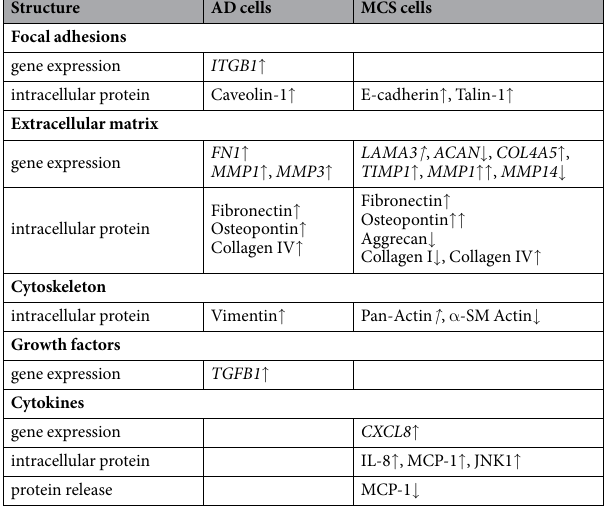
Table 1. Biochemical differences between adherently growing (2D) and multicellular spheroid cells (3D growth) of NHDF in s- µ g